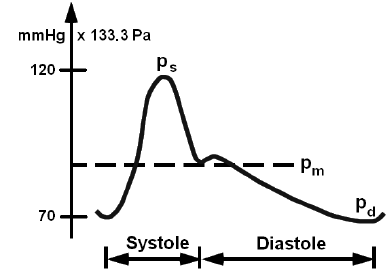
Fig. 1. A typical blood pressure waveform in the brachial